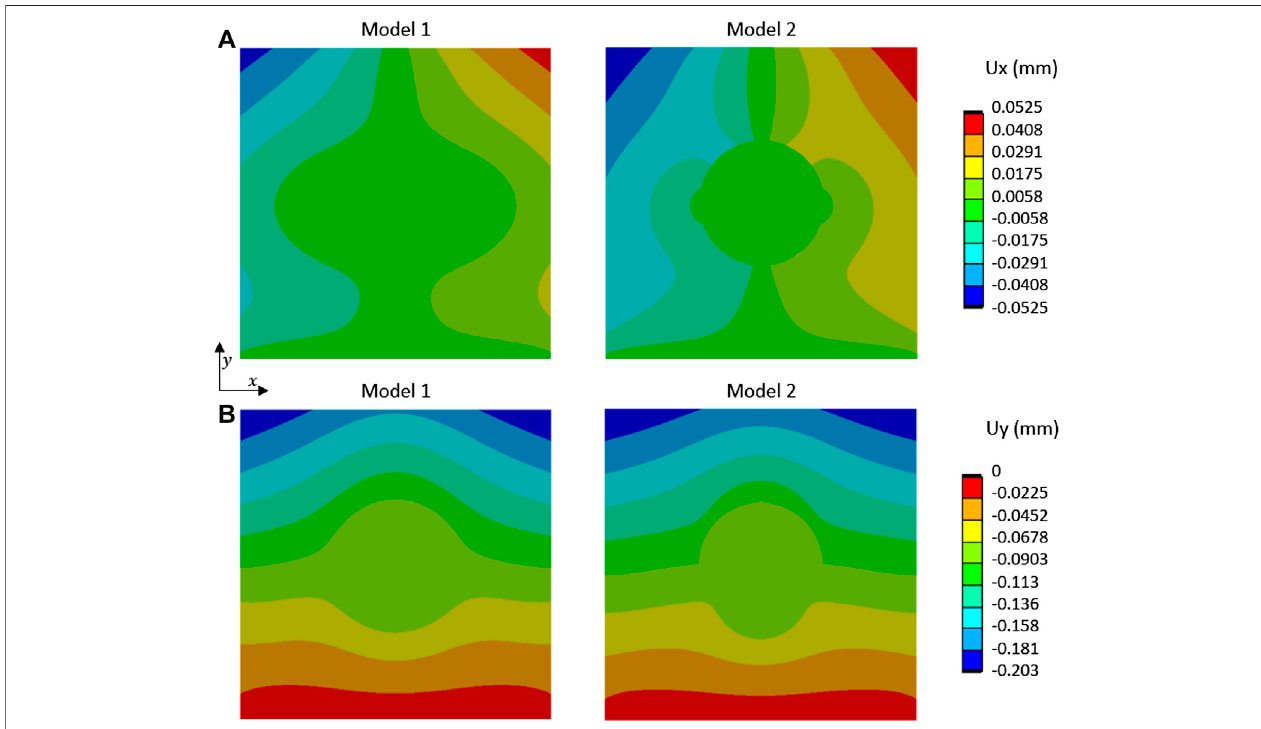
FIGURE 8 | Load vs. time plot for different sample con fi gurations: Sample 1 — cancellous bone, Sample 2 — cortical/cancellous in a longitudinal orientation, and Sample 3 — tibial plateau in a transverse orientation.